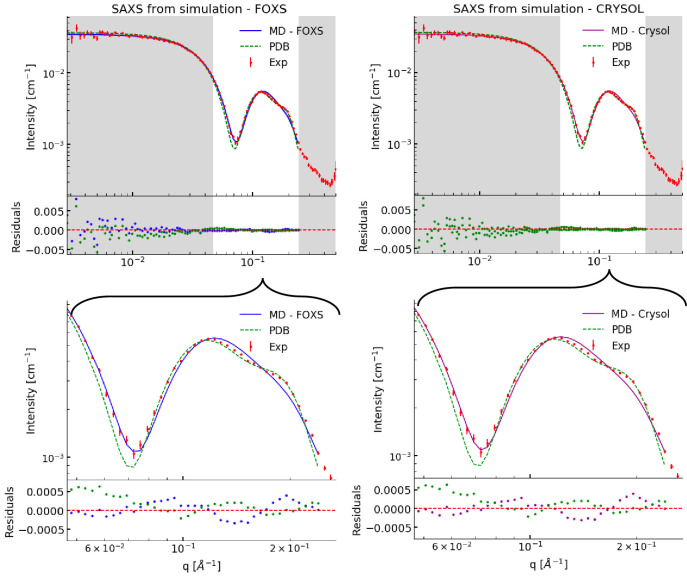
Comparing simulations with SAXS data.This figure is an expanded version of that in the main text, which shows only part of the q-range (marked in white).